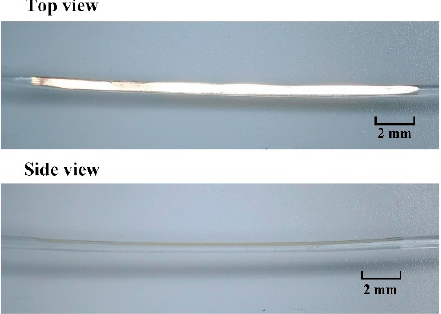
Figure 3. Photograph of the POF probe.